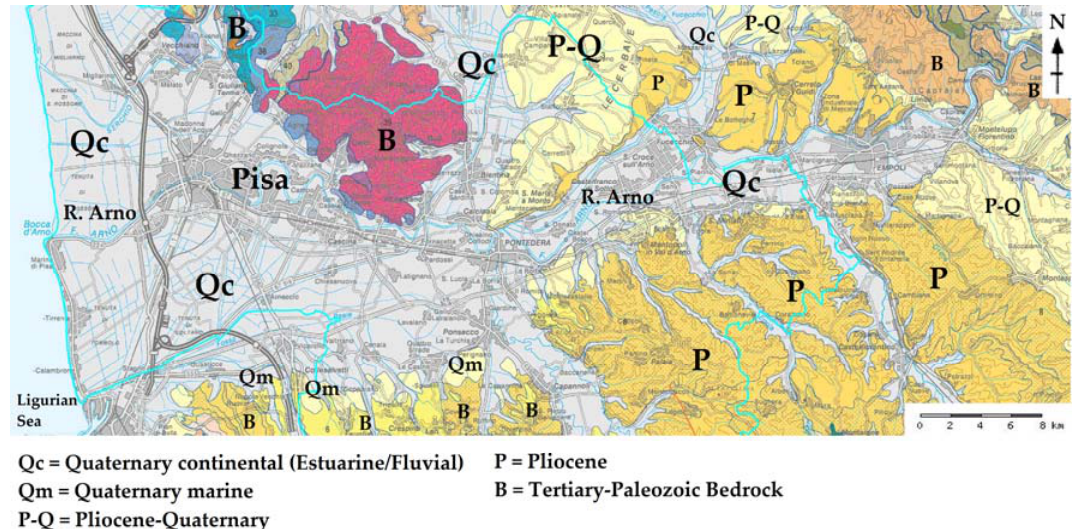
Figure 1. Geological map of the study area. (Adapted from: Consorzio Lamma Database [9]).